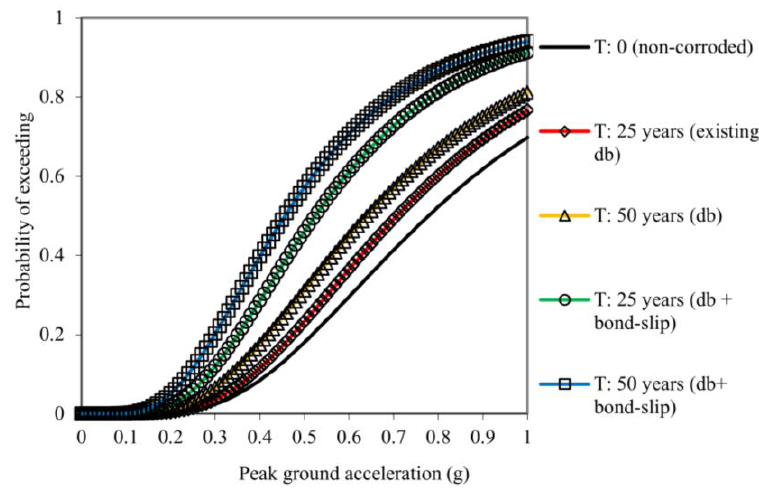
Fig. 14. Time-dependent fragility curves for the collapse prevention limit